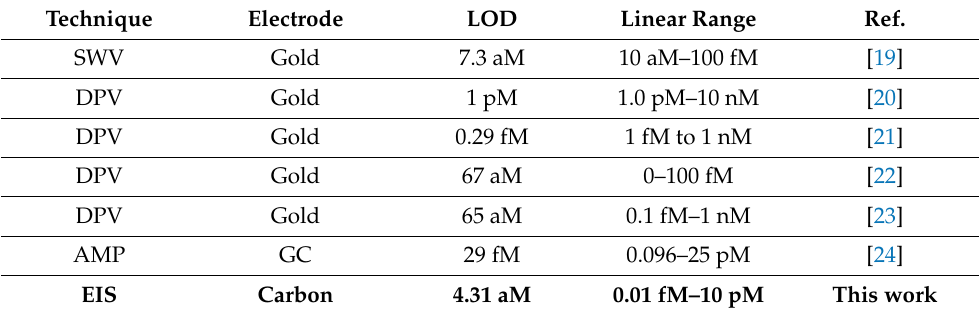
Table 1. Cont. Technique Electrode LOD Linear